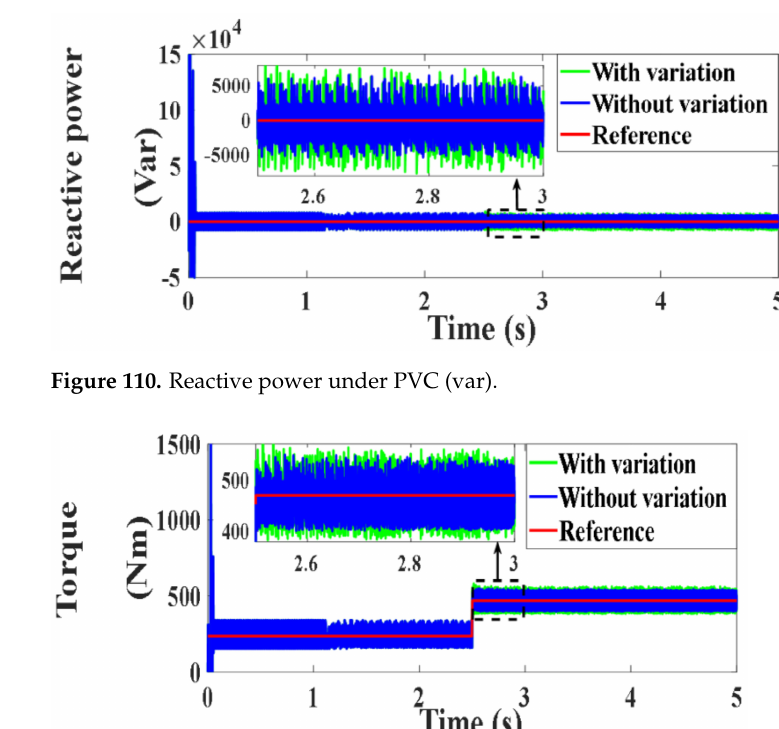
Figure 109. Active power under PVC (Watt).